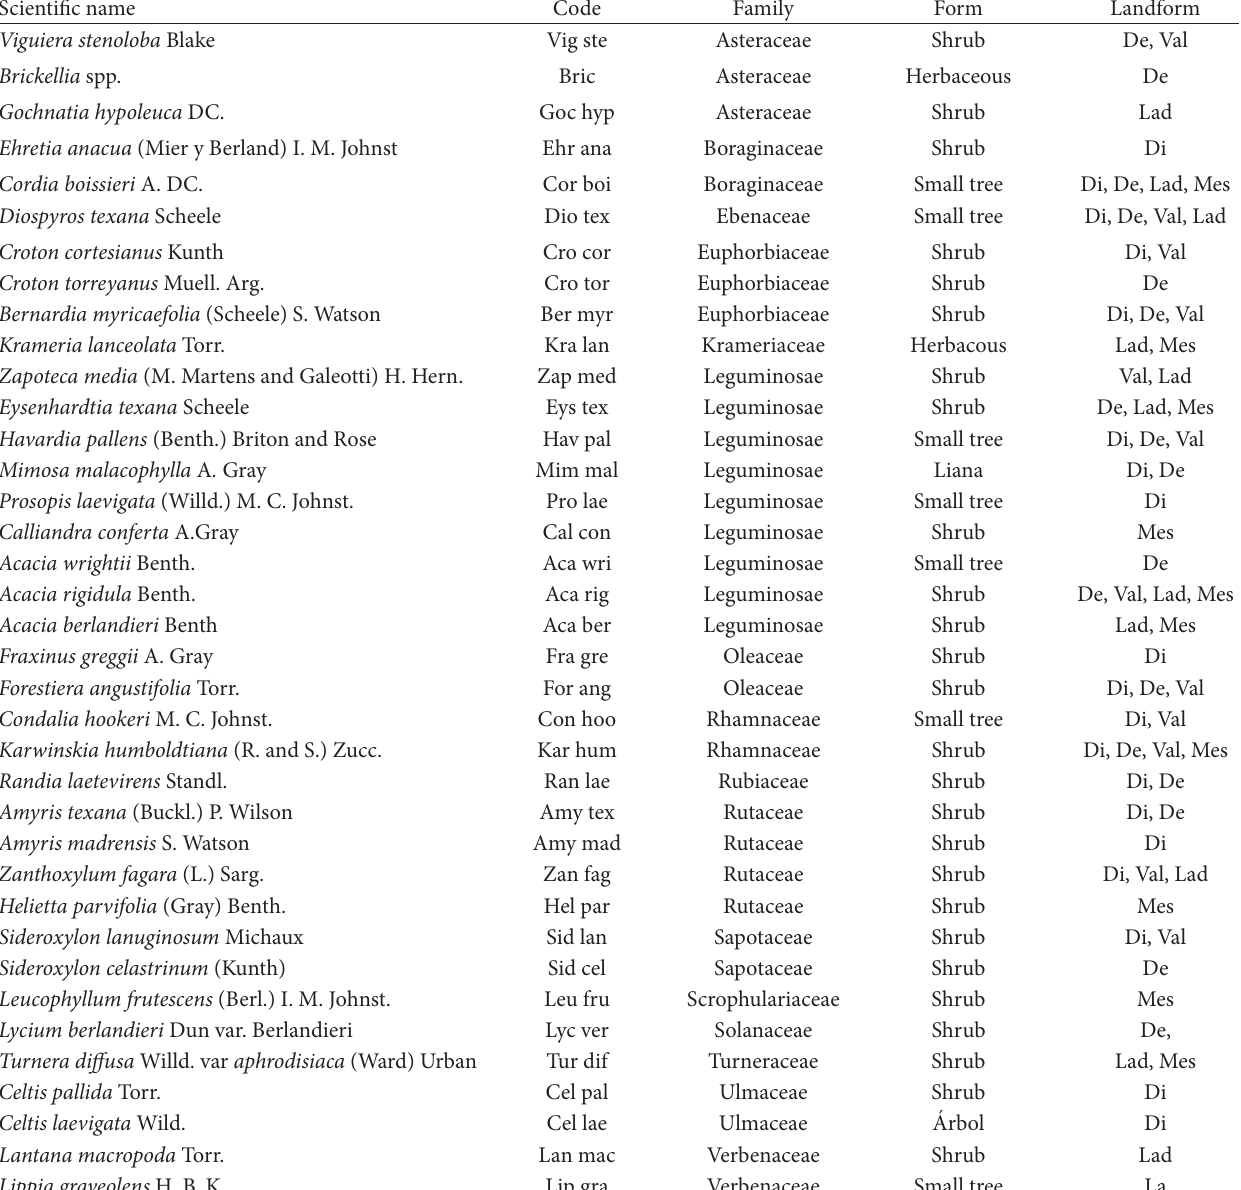
Table 1: Floristic listing of the present species in the sampling sites and the landforms on which they